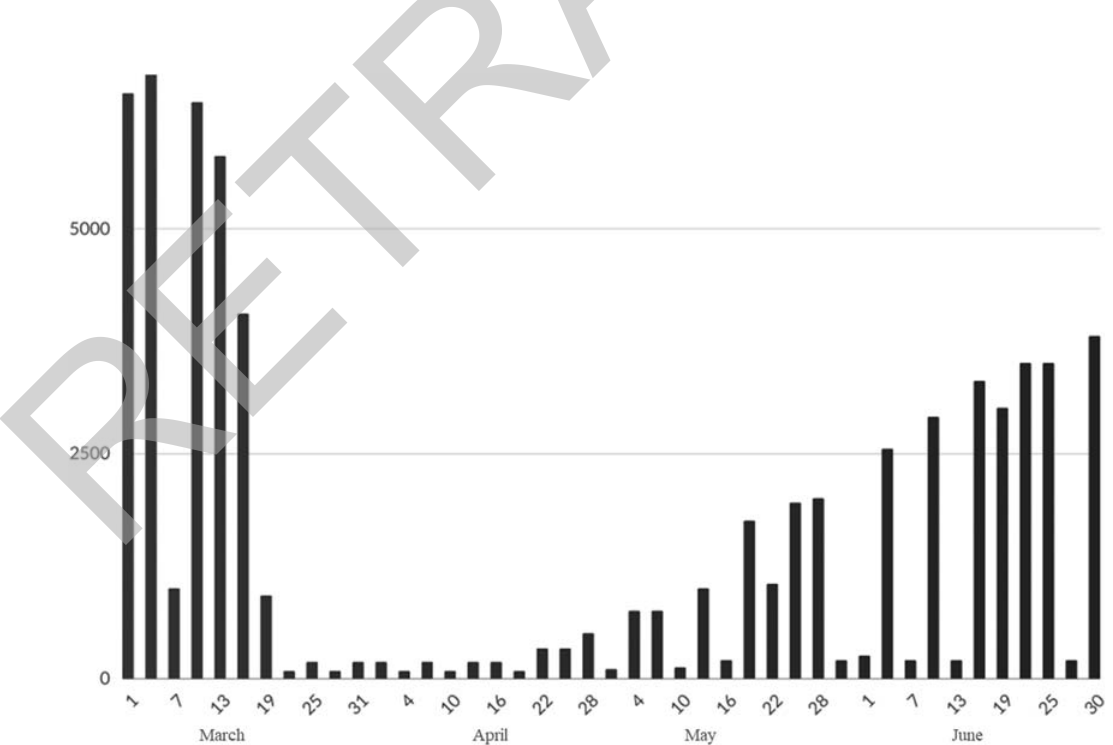
Figure 4: Number of CERN users at the site from March to June 2020 by CERN SUSI ( SUrveillance des SItes )